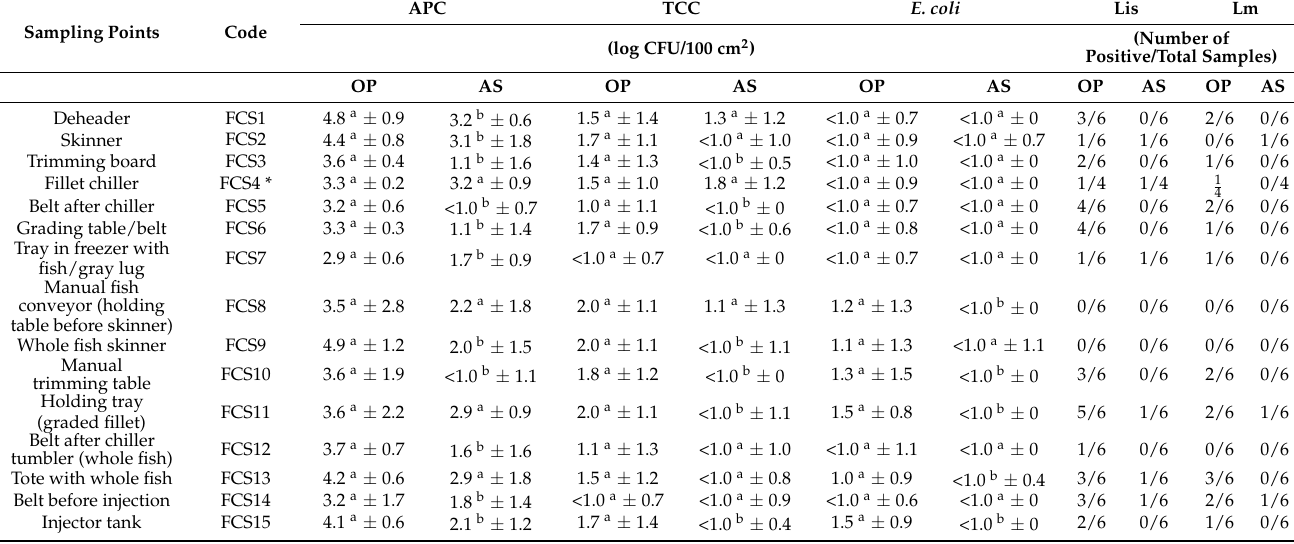
(14% and 10%, respectively) than during operation (37% and 21%, respectively) (Table 2). There were 11, 8, and 5 sampling points for APC, TCC, and E. coli counts, respectively, that had less ( p < 0.05) bacteria after sanitation (Tables 3 and 4). Table 3. Aerobic plate count (APC), total coliform count (TCC), generic E. coli count, Listeria spp. (Lis), and Listeria monocytogenes (Lm) prevalence on food contact surfaces (FCS) during operation (OP) and after cleaning and sanitation (AS).